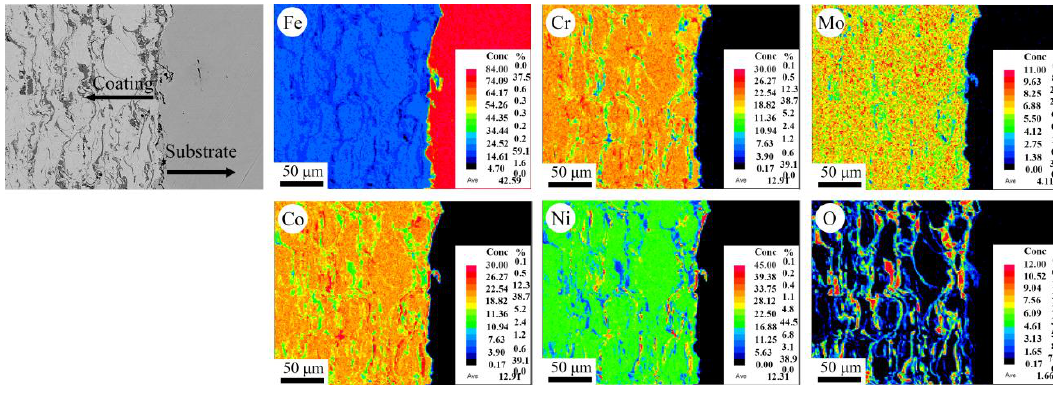
Figure 5. The elemental mapping with EPMA in the HVOF coating.